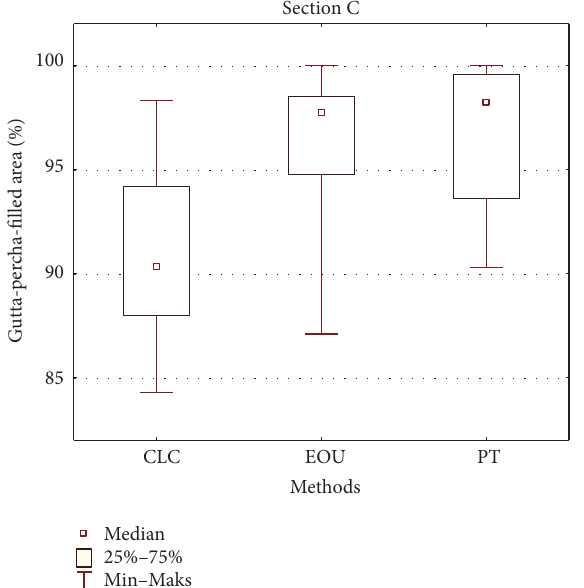
Figure 11: Box plots illustrating the median traces and minimal and maximal values of the voids in the filled area in each experimental group, section B.